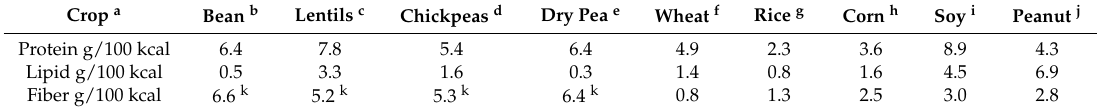
Table 7. Dietary fiber, protein, and lipid content of pulse and cereal crops per 100 kcal edible portion. Crop a Bean b Lentils